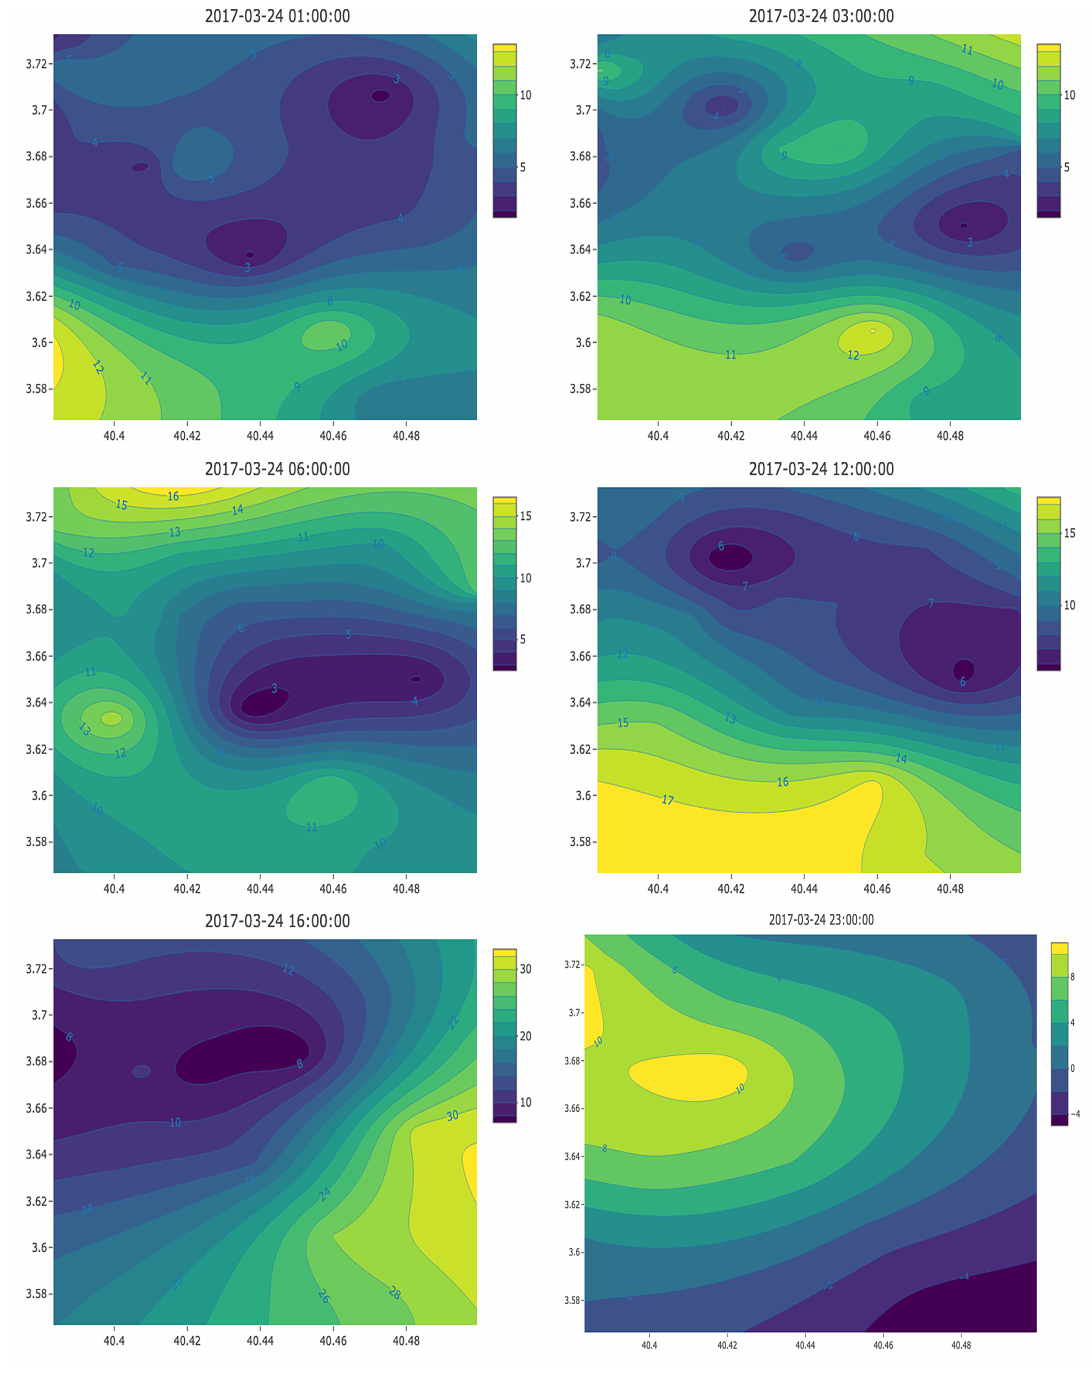
Figure 3. Co-kriging interpolation of PM 2.5 on 24 March